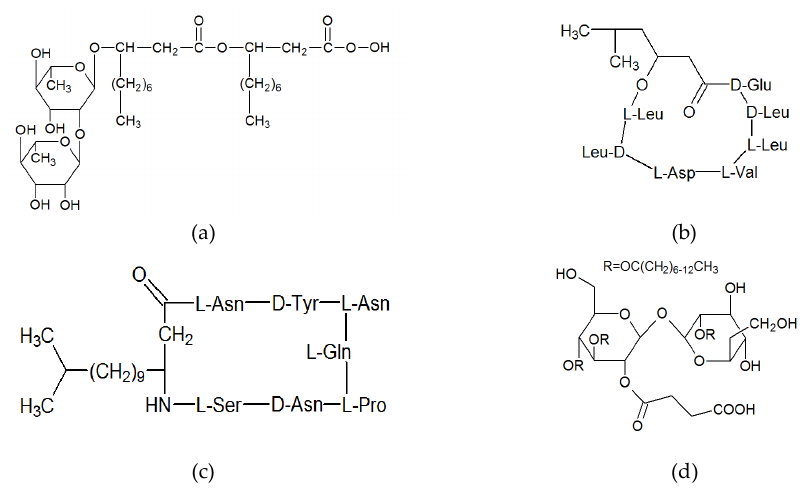
Figure 1. Structures of selected biosurfactants: ( a ) rhamnolipids [18], ( b ) surfactin [19], ( c ) iturin A [20], and ( d ) trehalose tetraester [21].